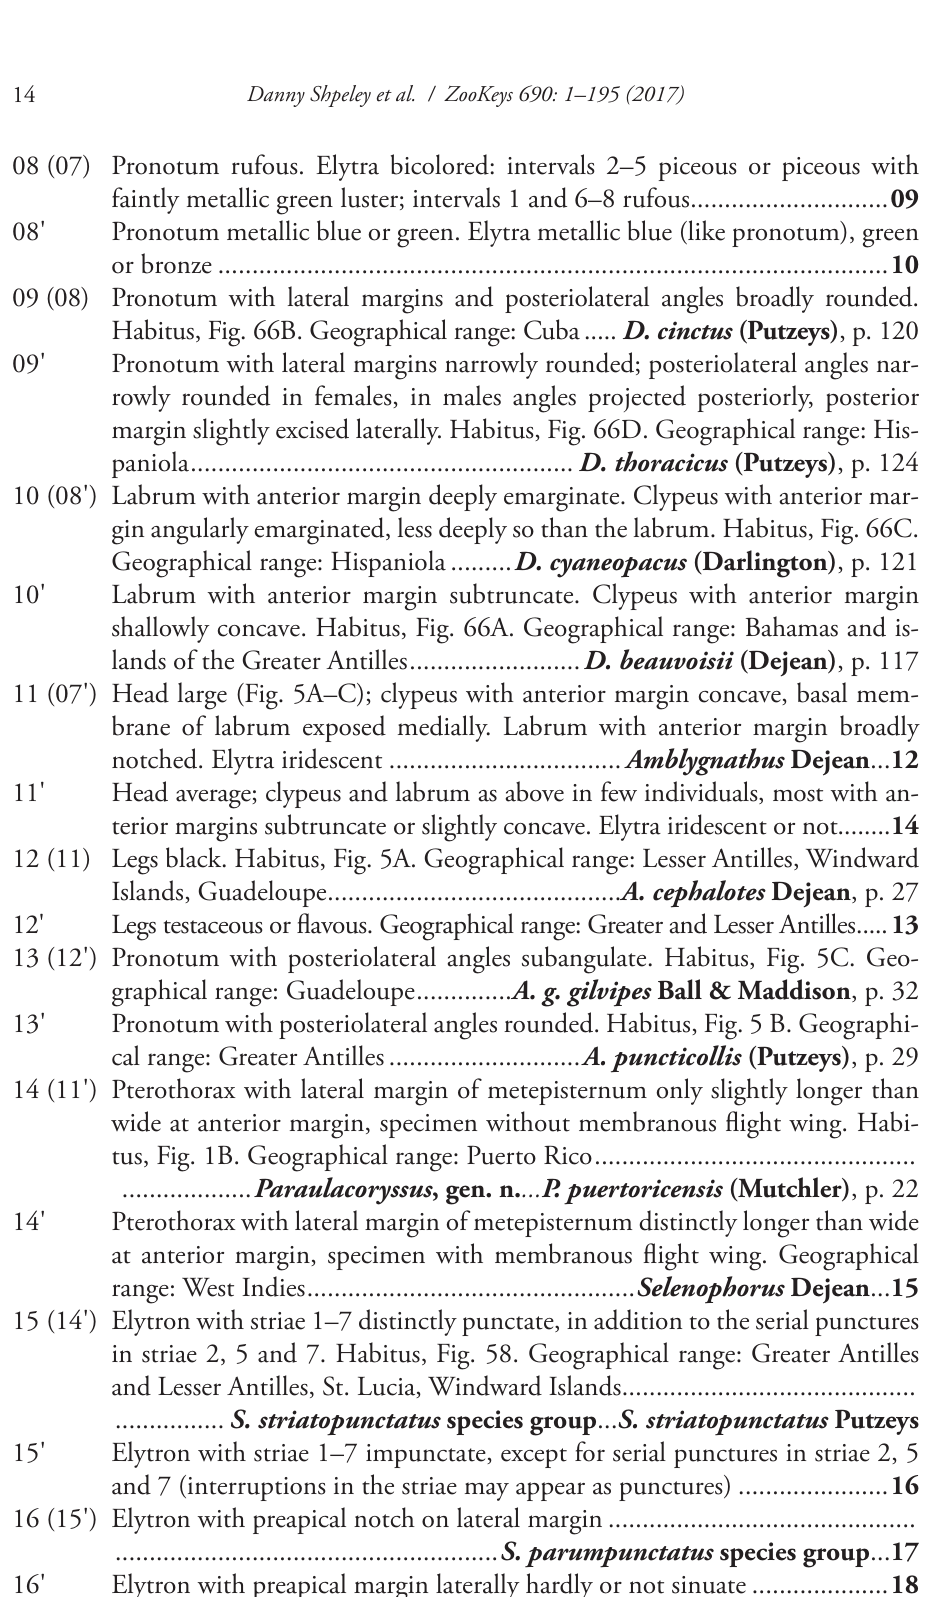
11 (07') Head large (Fig. 5A–C); clypeus with anterior margin concave, basal mem- brane of labrum exposed medially. Labrum with anterior margin broadly 11' Head average; clypeus and labrum as above in few individuals, most with an- terior margins subtruncate or slightly concave. Elytra iridescent or not........ 14 12 (11) Legs black. Habitus, Fig. 5A. Geographical range: Lesser Antilles, Windward 12' Legs testaceous or flavous. Geographical range: Greater and Lesser Antilles ..... 13 13 (12') Pronotum with posteriolateral angles subangulate. Habitus, Fig. 5C. Geo- Pronotum with posteriolateral angles rounded. Habitus, Fig. 5 B. Geographi- 14 (11') Pterothorax with lateral margin of metepisternum only slightly longer than wide at anterior margin, specimen without membranous flight wing. Habi-